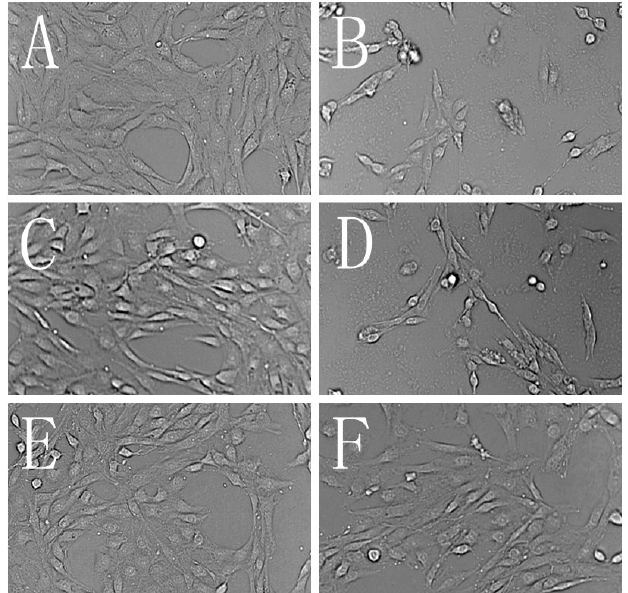
Figure 3. Morphological characteristics of PC12 cells. ( A ) Normal PC12 cells; ( B ) PC12 cells treated with 400 μ M H O for 90 min; ( C ) PC12 cells treated with pinocembrin at 2 2 high concentration (200 μ M) for 24 h; ( D ) PC12 cells treated with liquiritin at high concentration (200 μ M) for 24 h; (E) PC12 cells treated with pinocembrin at 3.125 μ M for 24 h before exposure to H O (400 μ M, 90 min); ( F ) PC12 cells treated with liquiritin 2 2